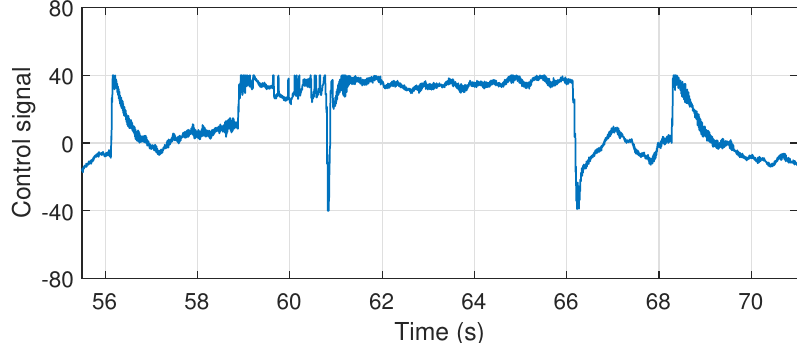
Figure 20. Control signal for yaw axis tracking.